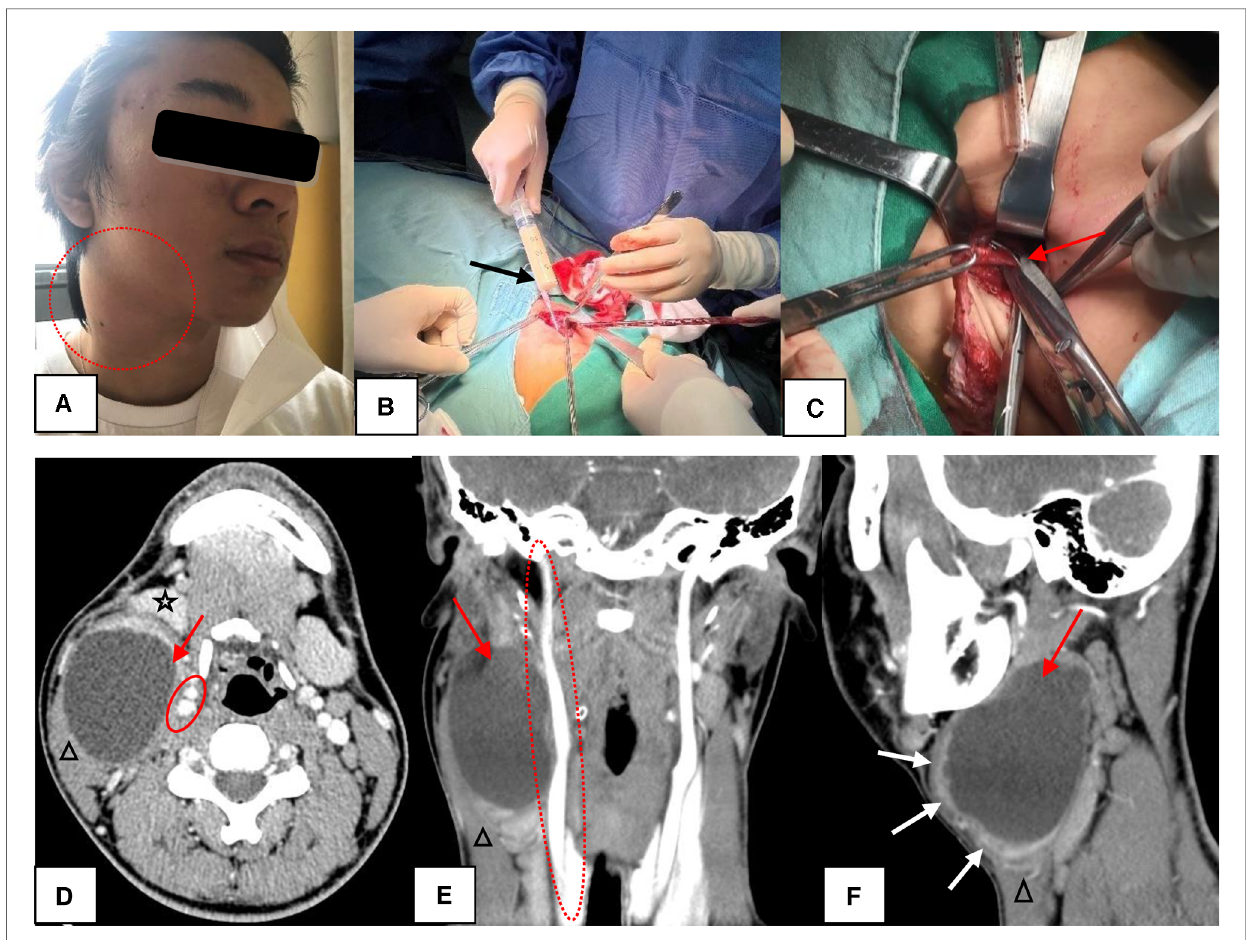
FIGURE 2 The Bailey type II. ( A ) The lesion presented as a painful mass in the right neck (circle). ( B ) During the operation, the mass contained a large amount of rice soup like liquid (black arrow). ( C ) High ligation of the sinus (red arrow) was suf fi cient for complete excision of CSBCAs. ( D – F ) CT scans showed a well- circumscribed and homogeneously low-density cystic mass (red arrow) with uniformly thin, smooth wall. If infected, the cyst wall became thickened and irregular (F, white arrow). The lesion was found in the “ classic ” location: along the anteromedial border of the SCM (triangle), lateral to the carotid sheath (circle), and posterior to the SMG ( fi ve-pointed star). D, axial position, E, coronal position, F, sagittal position; CSBCAs, congenital second branchial cleft anomalies; SCM, sternocleidomastoid muscle; CT, computed